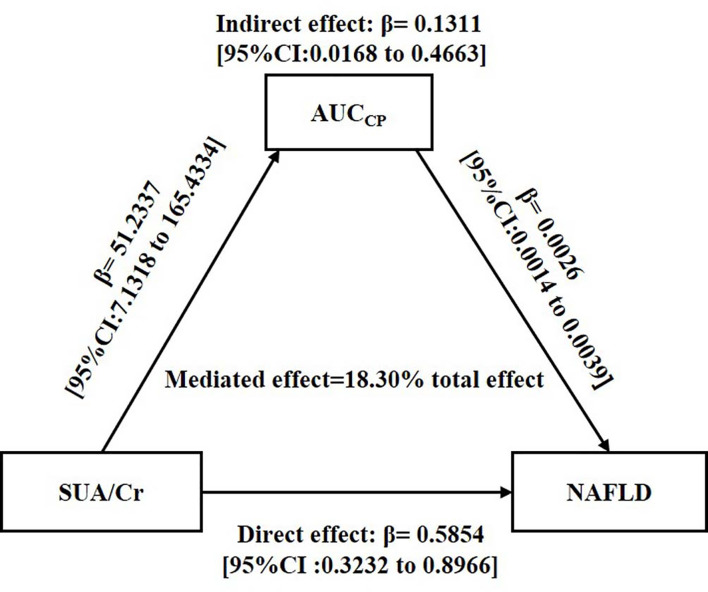
Mediation of AUCCP on the association between SUA/Cr and NAFLD. Zero was not included in 95% confidence intervals representing statistical significance. SUA/Cr, serum uric acid to creatinine ratio; AUCCP, area under the curve of C-peptide; NAFLD, non-alcoholic fatty liver disease.